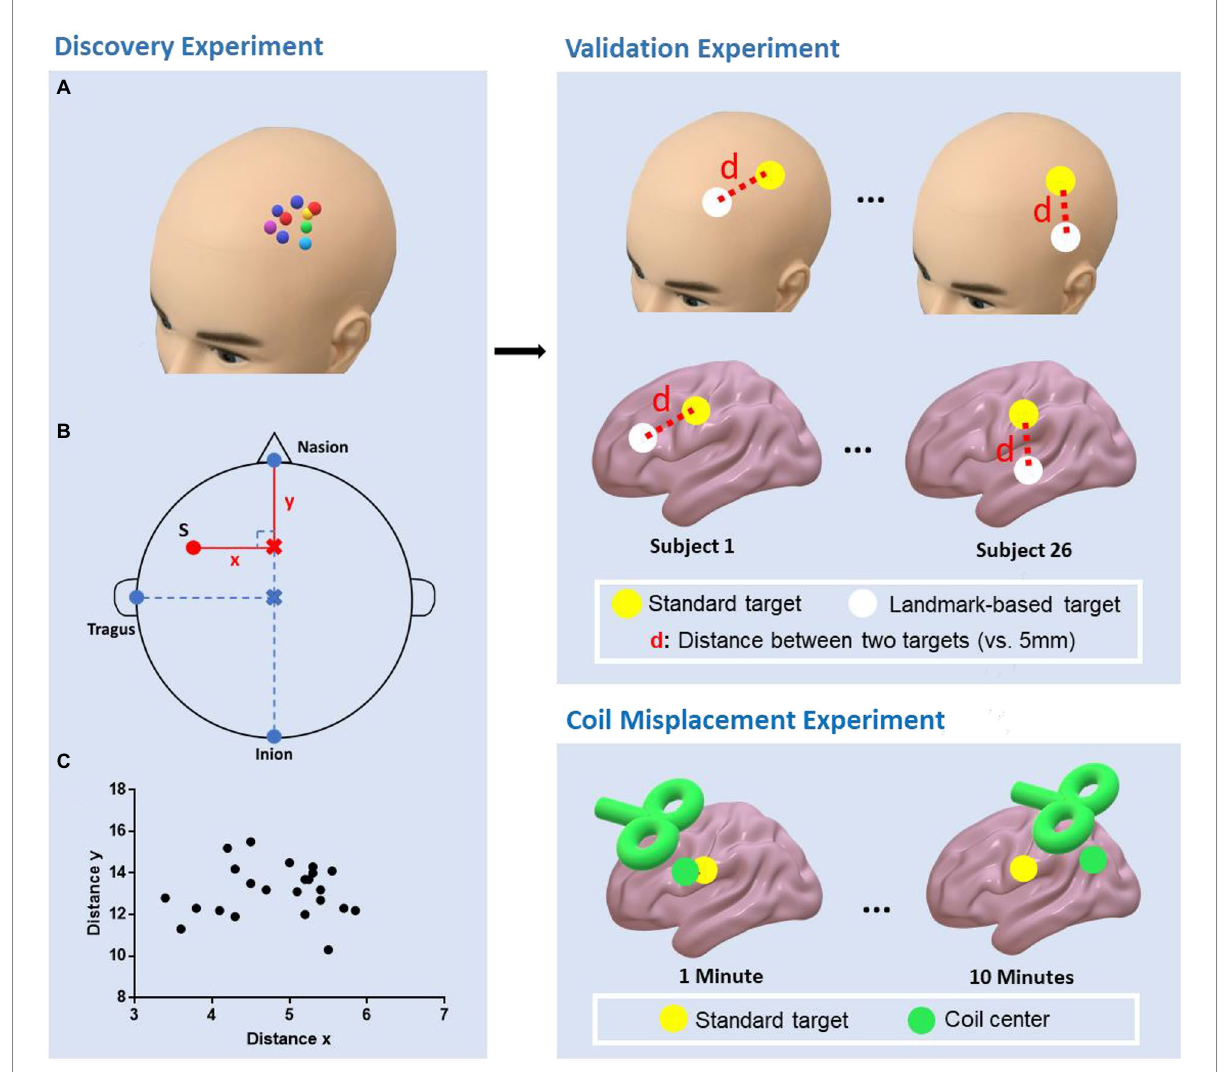
FIGURE 1 Study design of the experiments. Discovery experiment: The personalized targets were marked on the scalp using a neuronavigation system (A) ; The parameters (distance x , distance y , distance N-I , and distance V-T ) that were needed to determine the landmark-based approach were then measured. The personalized target was denoted as red point S (B) ; The distribution of distance x and y (C) . Validation experiment: The “landmark- based approach” was replicated in an independent cohort and the personalized and landmark-based target distances to the TMS spatial resolution (i.e., 5 mm) were compared. Coil misplacement experiment: The misplacement between the coil center and target was estimated over 10 min of stimulation without